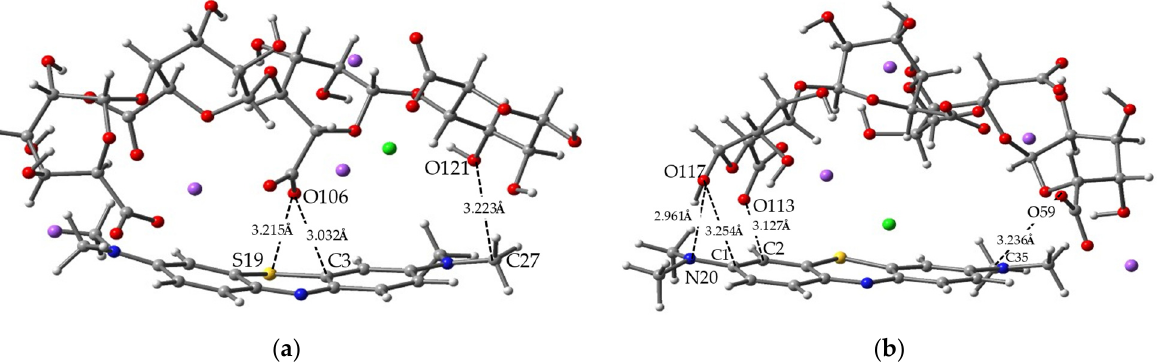
Figure 2. ( a ) The molecular structure of MB/SA 1 obtained at the B3LYP/6-31g(d) level. ( b ) The molecular structure of MB/SA 2 obtained at the B3LYP/6-31g(d) level. Weak intermolecular interactions observed are shown with broken lines with the distances in Å. (Blue ball = nitrogen (N), gray ball = carbon (C), yellow ball = sulfur (S), green ball = chlorine (Cl), red ball = oxygen (O), white ball = hydrogen (H), and purple ball = sodium (Na).)